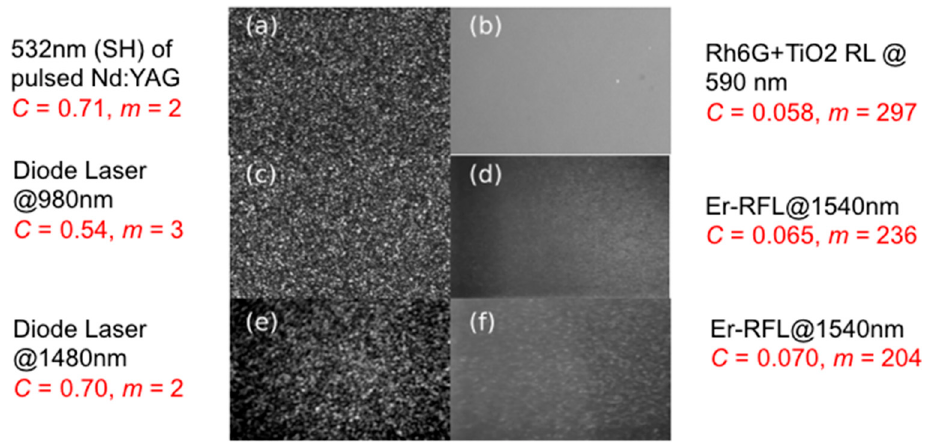
Figure 3. ( a , c , e ) display the measured speckle of the second harmonic of a pulsed Nd:YAG laser ( a ); a CW diode laser operating at 980 nm ( c ); and a similar diode laser, but operating at 1480 nm ( e ); ( b , d , f ) show a colloid random laser (RL) ( b ); the Er-RFL at 1540 nm pumped at 980 nm ( d ); and the same Er-RFL pumped at 1480 nm ( f ). The values of the speckle contrast C and number of longitudinal modes m for each optical source are indicated at the side. (Adapted with permission from ref. [69]).